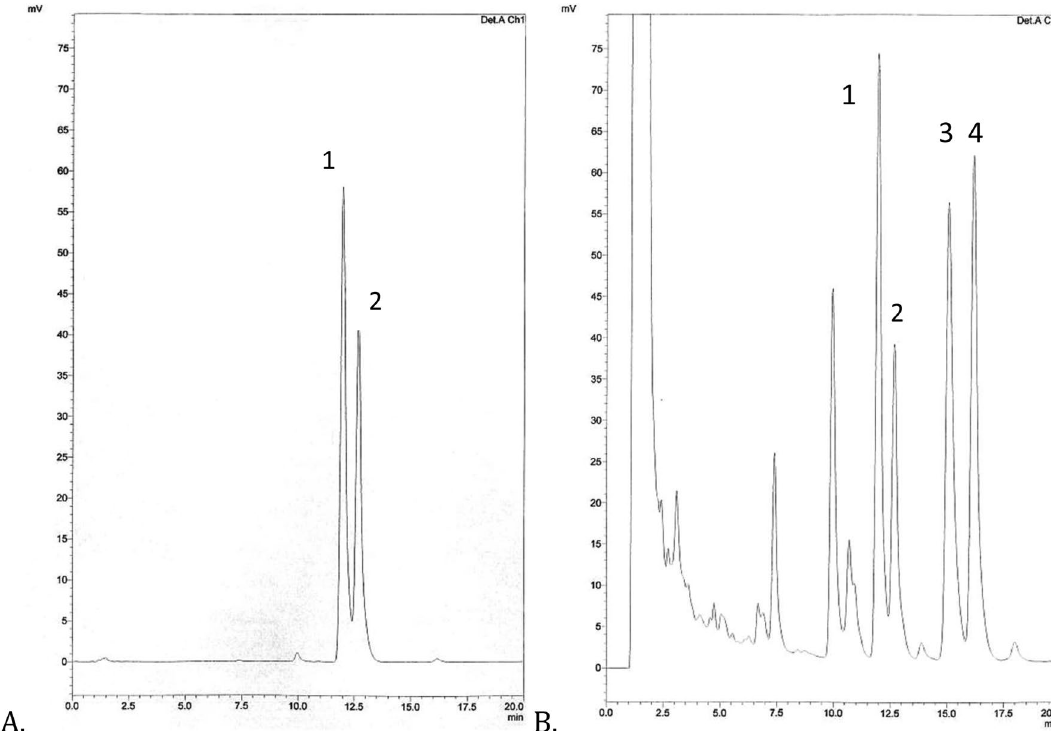
Figure 1. HPLC chromatograms of lignan fraction from the shoot culture of of P. amarus harvested on solid MS 0 medium ( B ), and standard compounds ( A ): 1—phyllanthin, 2—hypophyllanthin, 3—nirtetralin, 4— niranthin. Monolithic column HPLC Chromolith performance RP-18E 100–4.6, T = 25 °C, 0 min—40%